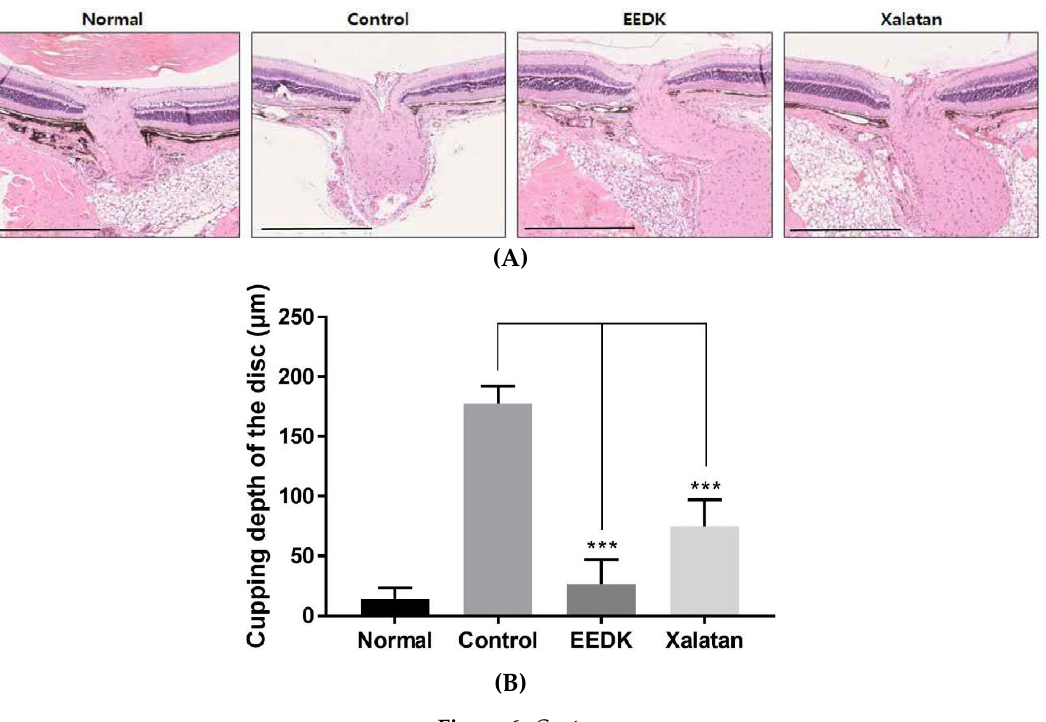
8 of 17 Figure 5. Effect of EEDK on b-wave amplitude in DBA/2 mouse. ( A ) Representative scotopic